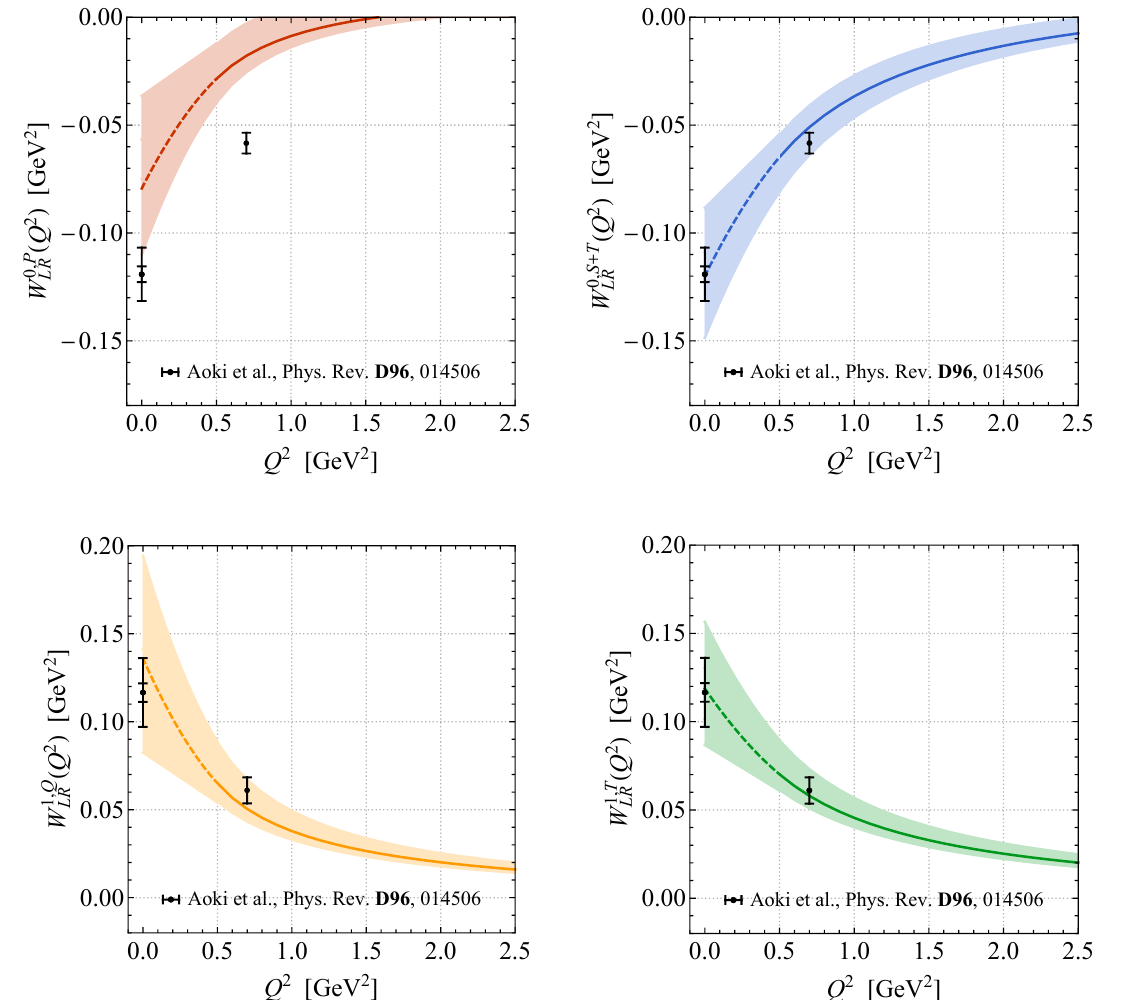
Figure 5 . As figure 4 but for the form factors W n,α